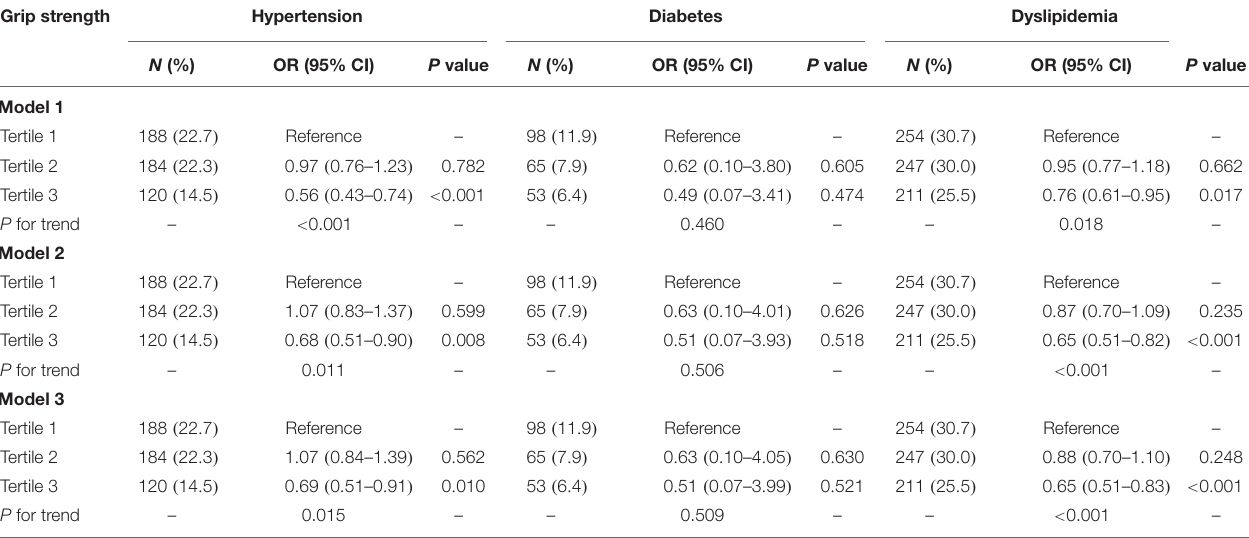
TABLE 2 | The associations between relative handgrip strength and cardiometabolic disorders in